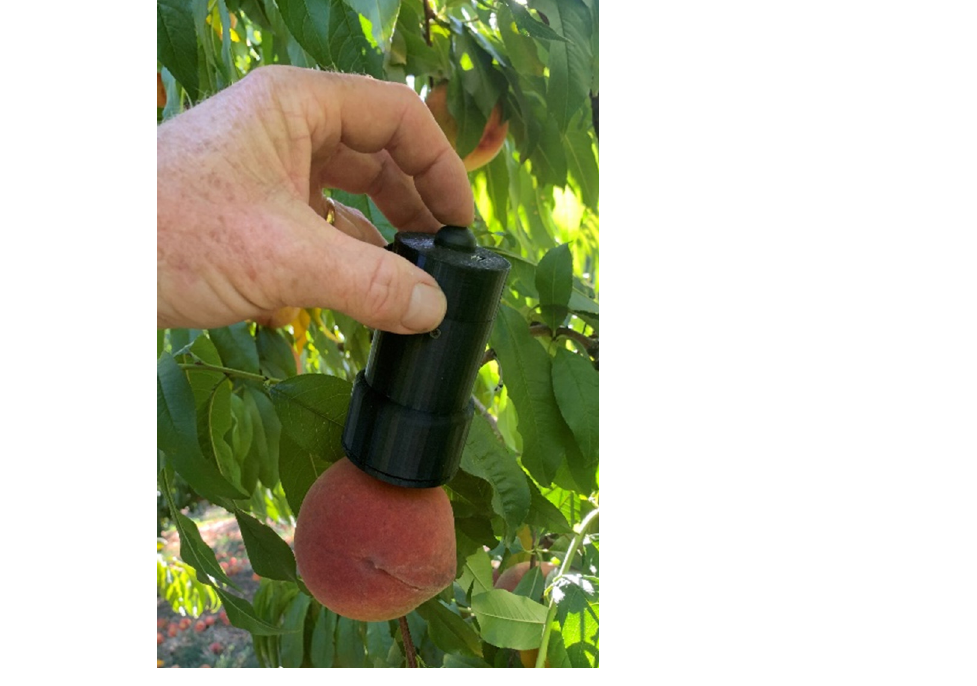
Figure 2. Portable Bluetooth colourimeter used for in situ measurement of L*, a* and b* and calcu- lation of C* and h° in a ‘September Sun’ peach